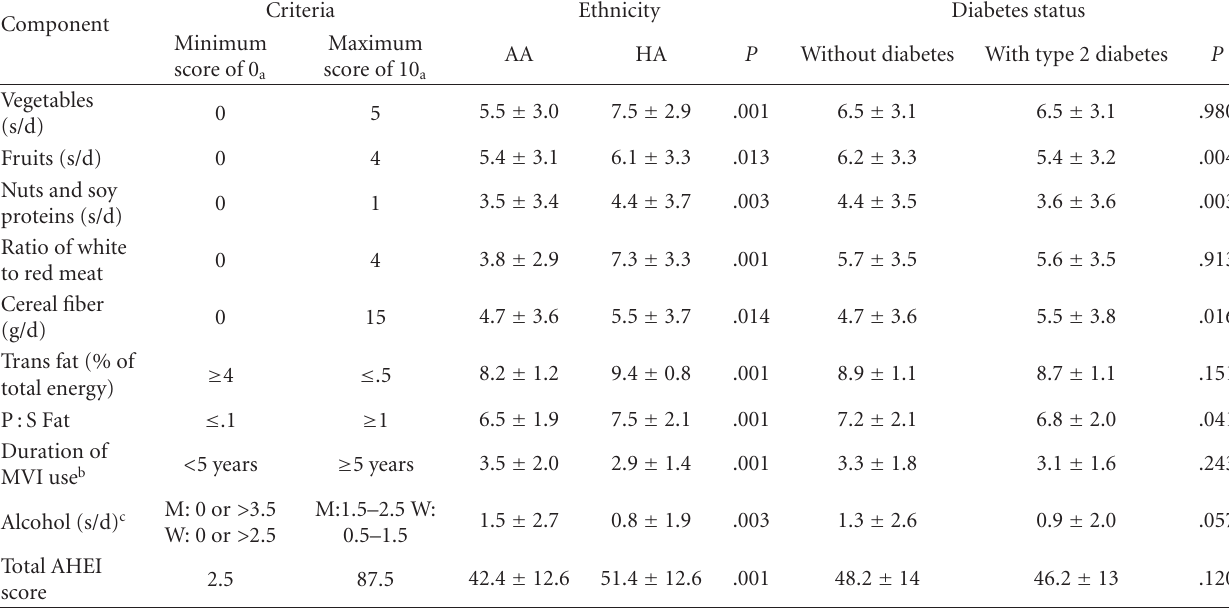
Table 3: Alternate Healthy Eating Index (AHEI) score components by ethnicity and diabetes status. Component